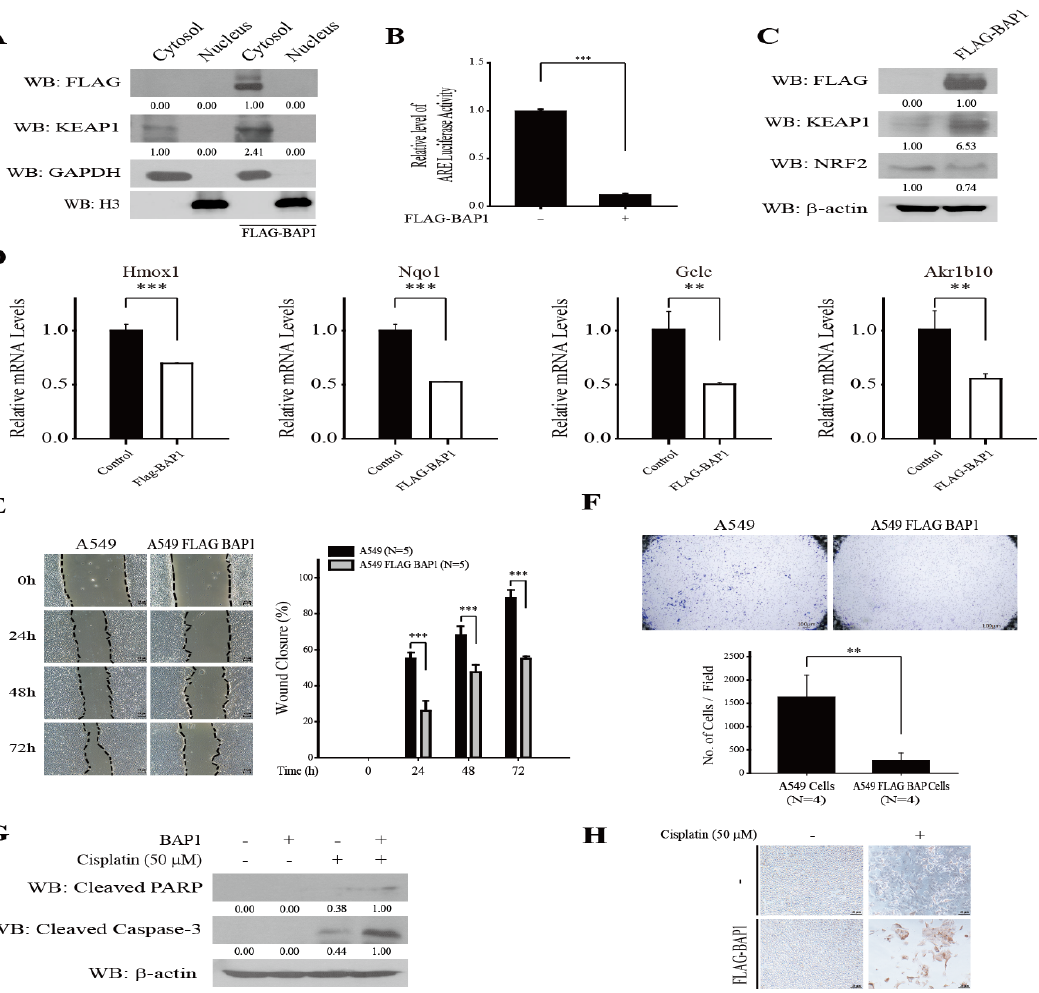
Figure 3. Overexpression of BAP1 suppresses NRF2 targets genes, inhibits the migration and inva- sion, and sensitizes cisplatin-induced apoptosis in A549 cells. ( A ) Lentivirally-transduced BAP1 is located in the cytosol of A549 cells. A549-FLAG-BAP1 cells were established by lentiviral transduc- tion with pLenti-puro-FLAG-BAP1 followed by selection with puromycin. A549-FLAG-BAP1 cells (2.5 × 10 6 cells/100 mm dish) were fractionated into the nucleus and the cytosol, and Western blot analysis was conducted against FLAG-HRP, KEAP1, GAPDH, and histone H3. GAPDH and His- tone H3 were used as indicative markers for the cytosol and the nucleus, respectively. ( B ) FLAG- BAP1 suppresses ARE-luciferase activity. A549 cells (5 × 10 5 cells/24 well dish) and A549-FLAG- BAP1 cells (5 × 10 5 cells/24-well dish) were cotransfected with 0.1 μ g of pGL3-ARE-luciferase and 0.1 μ g of pGL4.74 vectors, and the firefly luciferase activity was measured. The firefly luciferase activity was normalized by the renilla luciferase activity. ( C ) Overexpression of BAP1 increases KEAP1 and decreases NRF2 in A549 cells. A549 cells (2.5 × 10 6 cells/100 mm dish) were transfected with 1 μ g of pcDNA3-FLAG-BAP1 and Western blot analysis was conducted against FLAG, KEAP1, and NRF2. ( D ) The relative mRNA level of NRF2 target genes (Hmox1, Nqo1, Gclc, Akr1b10) was compared between A549 cells (5 × 10 6 cells/100 mm dish) and A549-FLAG-BAP1 cells (5 × 10 6 cells/100 mm dish) by real-time RT-PCR analysis. The primer sequence of individual genes is pro- vided in Table 1. ( E ) BAP1 suppresses the migration of A549 cells. The wound closure of A549 cells and A549-FLAG-BAP1 cells was monitored for 24 h, 48 h, and 72 h (left panel), and the percentage of wound closure was plotted (right panel). ( F ) BAP1 suppresses the invasion of A549 cells. The number of migrated cells to the lower chamber was manually counted under the microscope after 6 h (upper panel) and plotted (lower panel). ( G ) Western blot analysis demonstrates that BAP1 sen- sitizes A549 cells to cisplatin-induced apoptosis. A549 cells were transfected with 1 μ g of pcDNA3- FLAG-BAP1 and exposed to cisplatin for 24 h. Western blot analysis was conducted with Cleaved